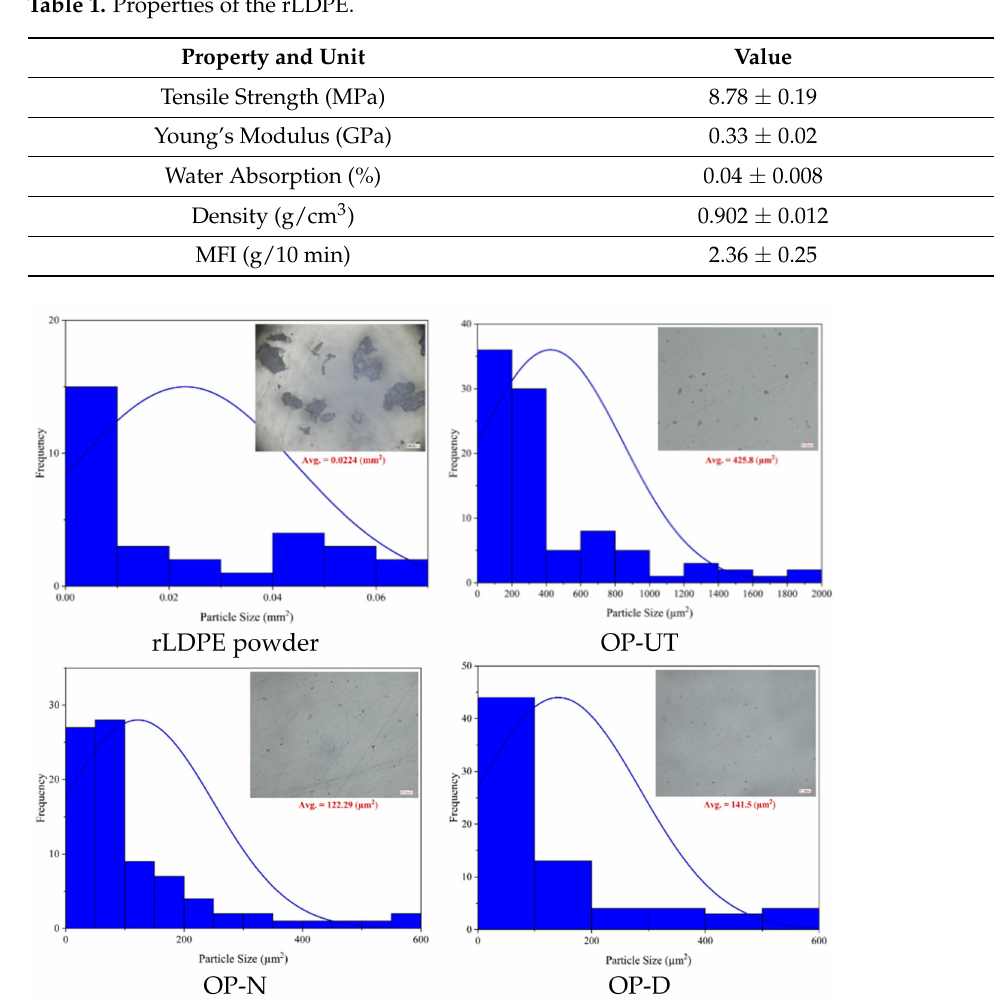
Figure 1. Particle size measurements of the used